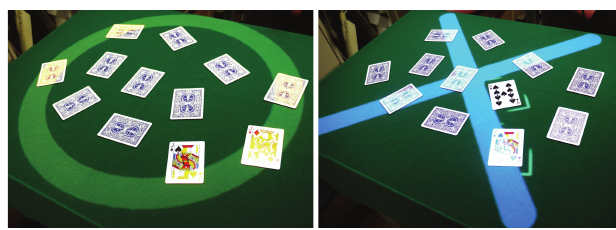
Figure 7. Feedbacks for equivalent (left) and nonequiva- lent (right).